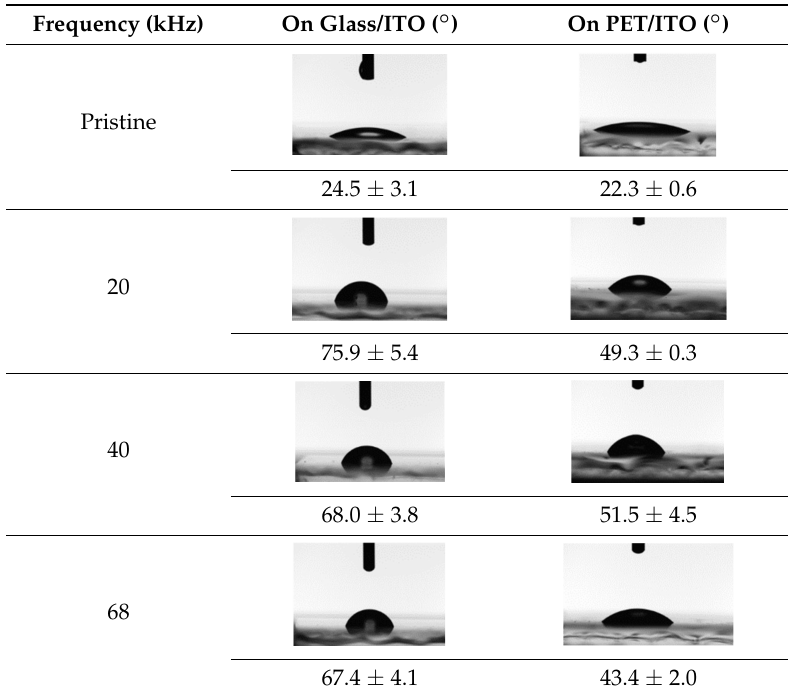
Table 2. Contact angle of water droplets on PEDOT:PSS films spun on glass/ITO and PET/ITO substrates. The diameter of the needle is 0.7 mm, and can be regarded as the scale